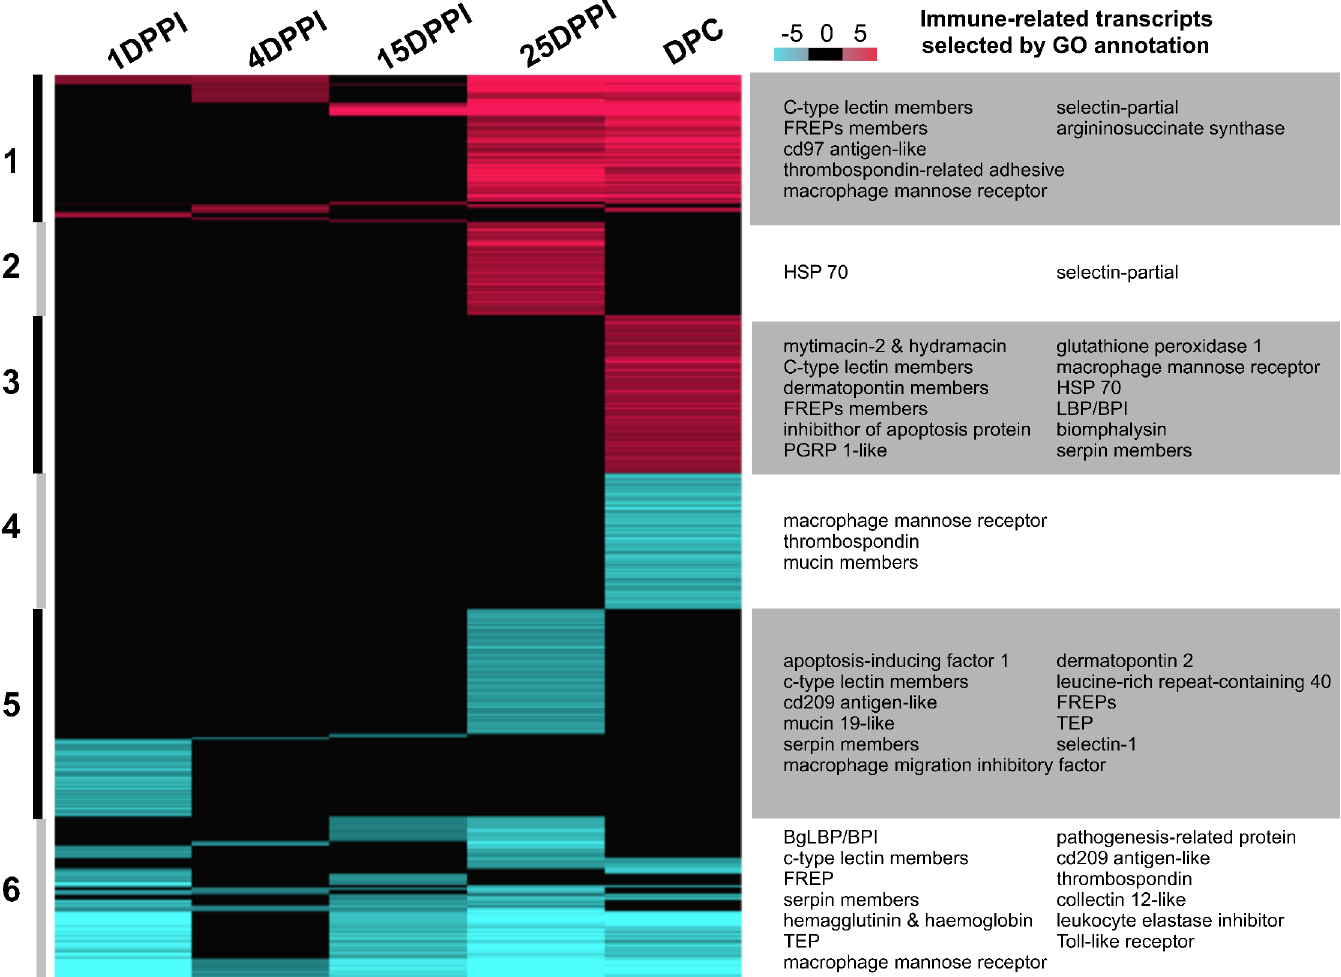
Fig 3. RNAseq analysis of the innate immune memory response of B . glabrata to S . mansoni . Heatmap showing differentially represented transcripts compared to na ï ve snails, as identified by DESeq2 analysis (p < 0.1). Color scale indicates the Log2FC ratio from under-represented (blue) to over- represented (red) transcripts. Transcripts were grouped into six clusters based on their expression patterns during the process of innate immune memory. Samples were recovered at 1DPPI, 4DPPI, 15DPPI and 25DPPI following primo-infection. Following secondary challenge samples were recovered at 1 day, 4 days and 15 days and pooled into DPC sample. Six clusters are identified: Cluster 1: transcripts over represented more than once all along infection and challenge. Cluster 2: transcripts exclusively over represented in single one condition. Cluster 3: transcripts exclusively over represented after immune challenge (DPC). Cluster 4: transcripts exclusively under represented after immune challenge (DPC). Cluster 5: transcripts exclusively under-represented in single one condition. Cluster 6: transcripts under represented more than once all along infection and challenge. FREP: Fibrinogen-related protein, HSP: Heat-shock protein, PGRP 1-like: Pathogenesis-related protein 1-like, LBP/BPI: lipopolysaccharide-binding protein/bactericidal/permeability-increasing protein, BgLBP/BPI: Biomphalaria glabrata LBP/BPI, TEP: thioester-containing